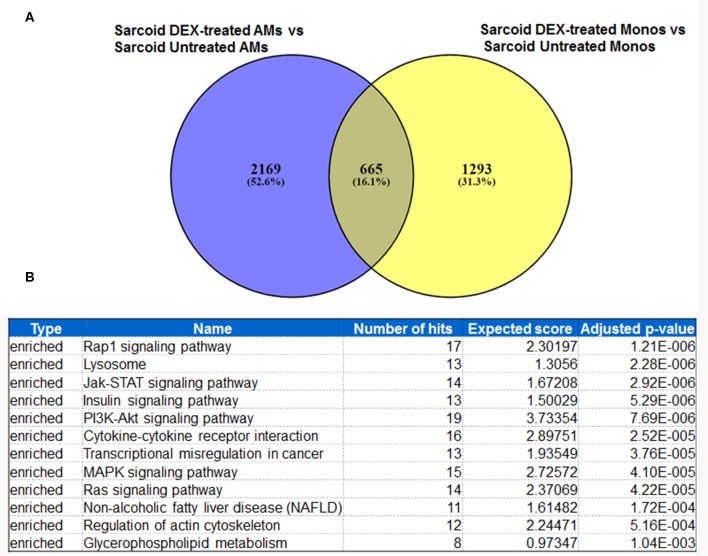
Metanalysis of DE genes between two groups: DEX-treated vs. untreated sarcoid AMs and DEX-treated vs. untreated sarcoid monocytes. (A) Venn diagram of DE genes showing 2,169 DE genes exclusively expressed in DEX-treated sarcoid AMs whereas 1293 DE genes were exclusively expressed in DEX-treated sarcoid monocytes. 665 DE genes overlap between the two groups (B) GeneTrail pathway analysis of common 665 DE genes between DEX treated sarcoid AMs and DEX treated sarcoid monocytes shows top 12 enriched significant pathways.